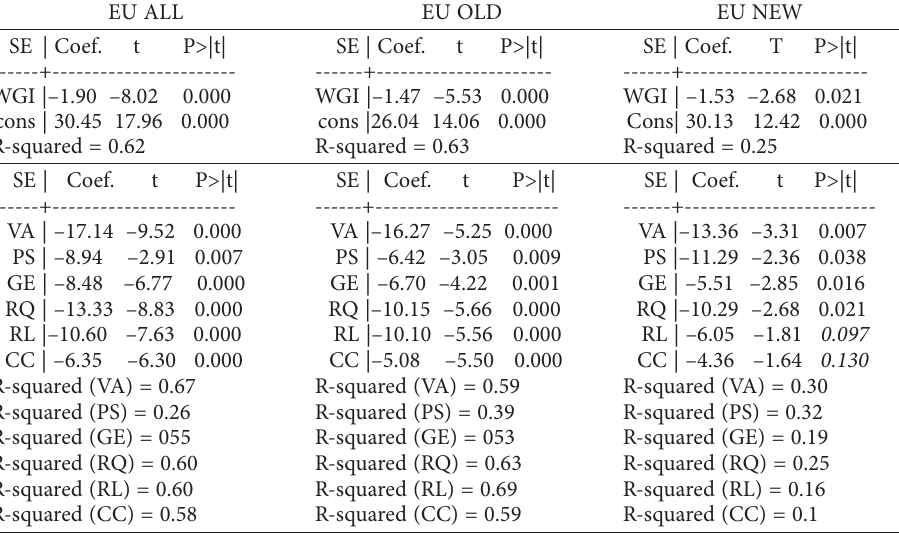
Table 6. Linear regression between SE and WGI (also including the components of WGI) EU ALL EU OLD EU NEW SE | Coef.